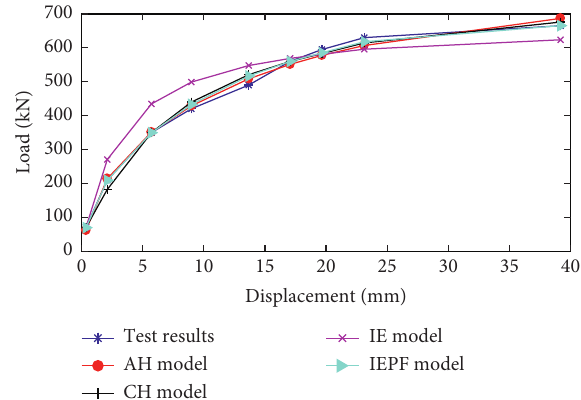
Figure 4: Comparison of each model with the test data from A